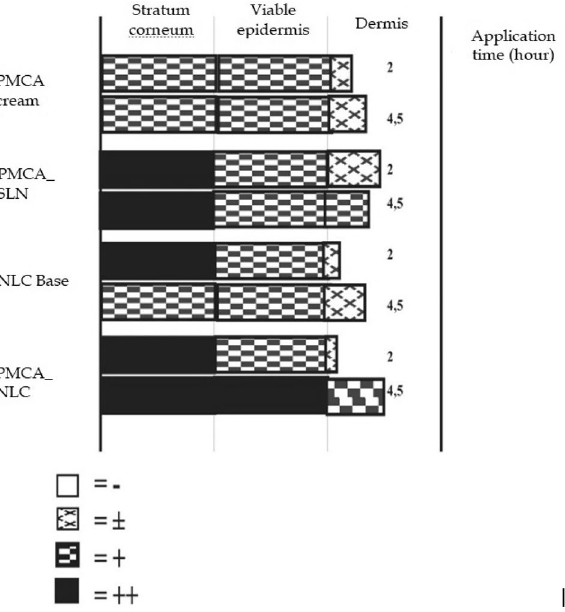
Figure 4. Intensity of fluorescence of PMCA cream, PMCA_SLN, NLC base and PMCA_NLC after the 2nd and 4.5th hour of application.